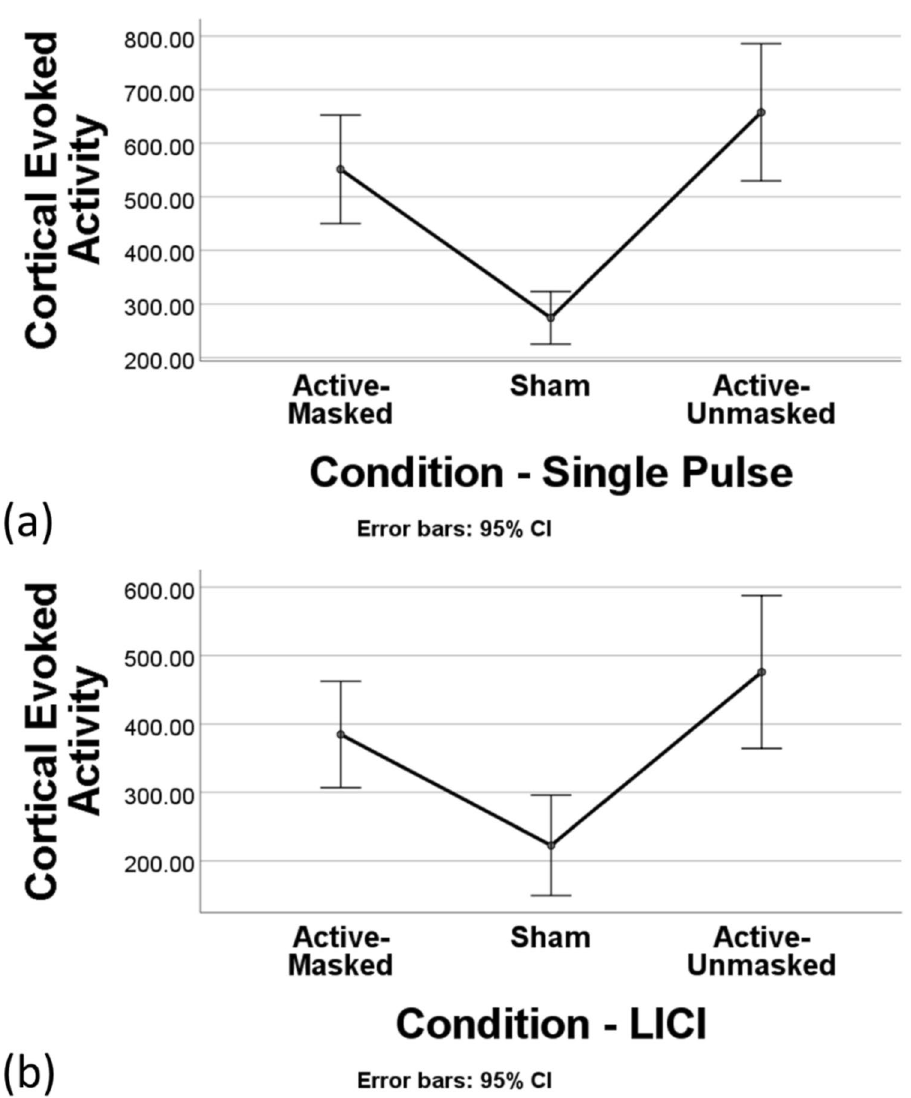
Figure 3. ( a ) Comparison of cortical evoked activity (CEA (25–275 ms) ) from electrodes F3 of the three single-pulse (SP) stimulation conditions using one-way repeated measure ANOVA. ( b ) Comparison of CEA (25–275 ms) from electrode F3 of the three conditions in paired pulse/ long interval cortical inhibition protocol (PP/ LICI) using one way repeated measure